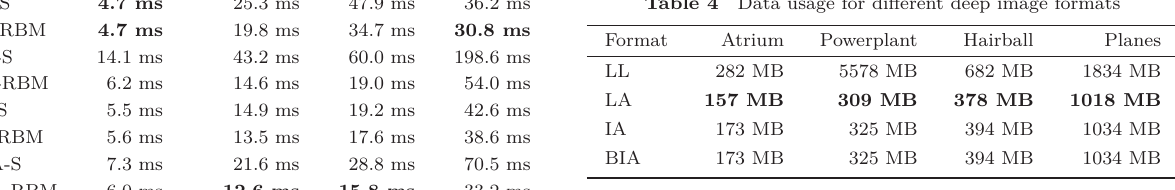
Table 2 Merging time for two input deep images, saving result as a deep image Approach